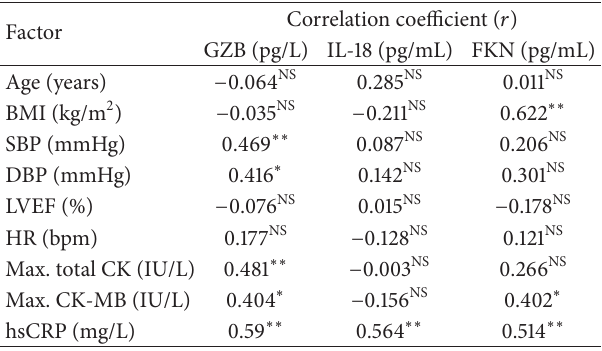
Table 4: Correlation coefficients of GZB, IL-18, and FKN with anthropometric and clinical data in ACS patients.